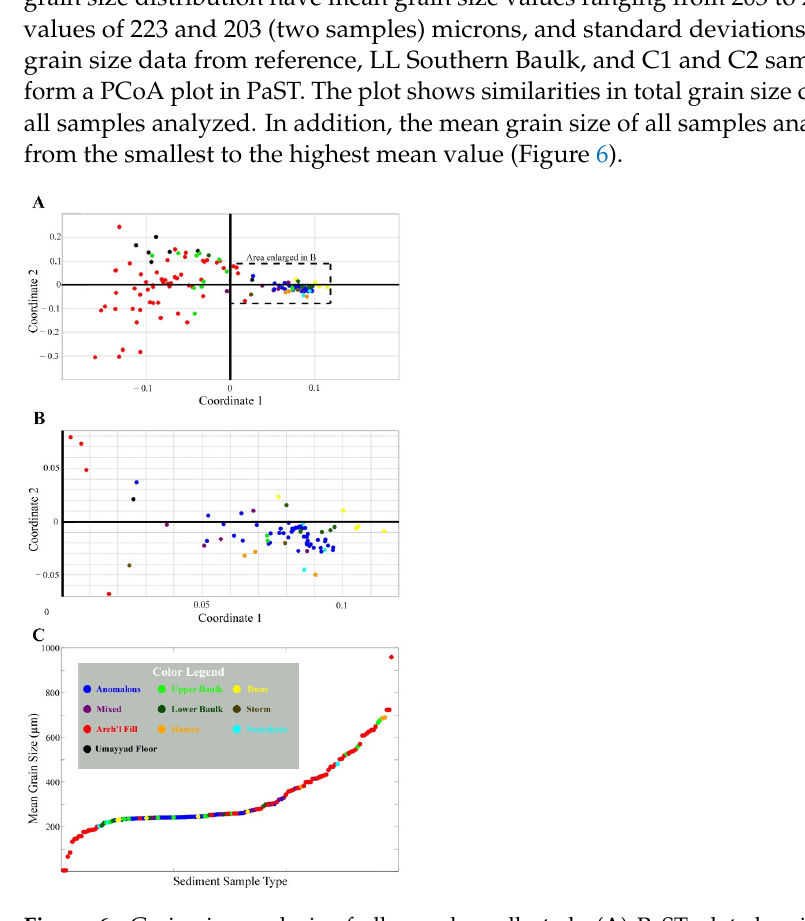
Figure 6. Grain size analysis of all samples collected. ( A ) PaST plot showing the similarity in grain size distribution among all sediment samples analyzed, using principal coordinate analysis. ( B ) Expanded view of samples in outlined region. ( C ) Mean grain size values, plotted from lowest to highest, of all sediment samples analyzed. Refer to Figure 1 for sample collection locations.